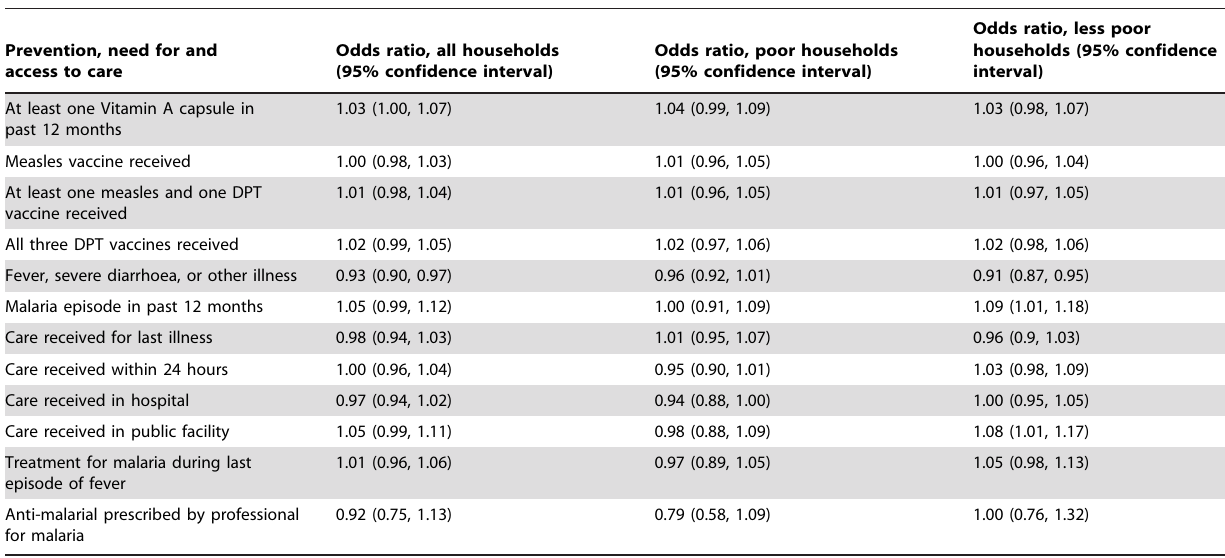
Table 6. Relationship of gender to prevention and need for and access to curative care among children , 5 years old*.